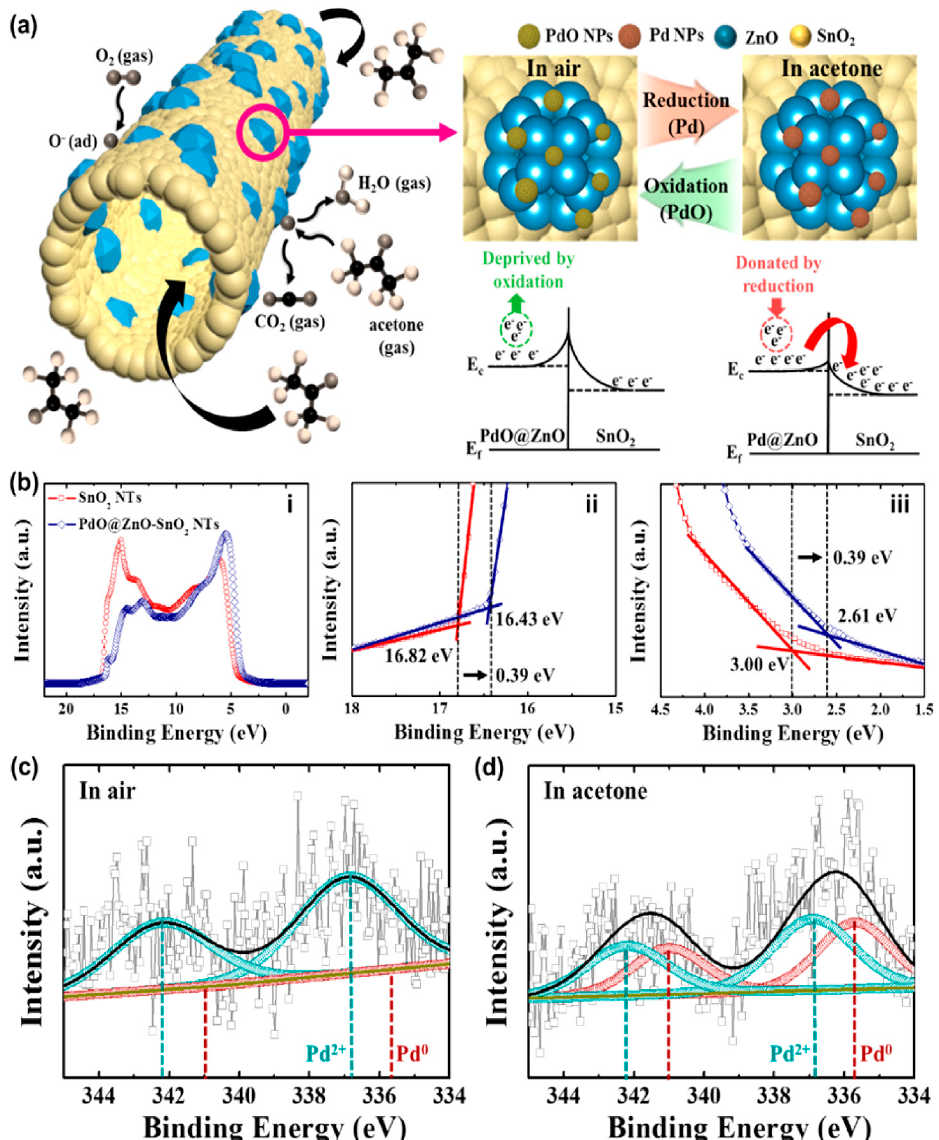
Figure 13. ( a ) Schematic illustration of acetone-sensing mechanism for PdO@ZnO–SnO 2 nanotubes NTs; ( b ) (i) ultraviolet photoelectron spectroscopy (UPS) spectrum of SnO 2 NTs and PdO@ZnO–SnO 2 NTs ((ii) high-binding-energy region and (iii) low-binding-energy region) and ex situ X-ray